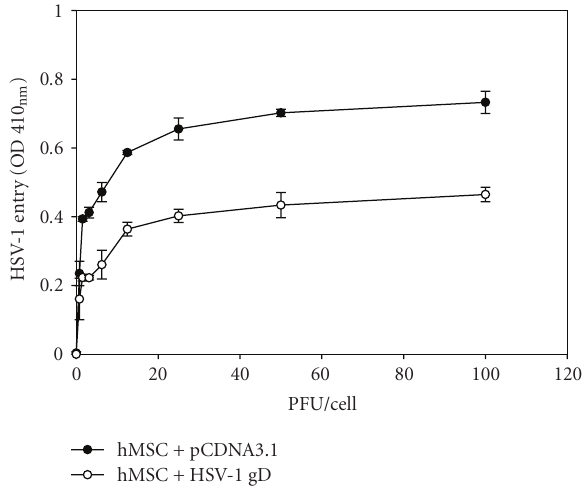
Figure 4: HSV-1 glycoprotein D (gD) receptors are important for infection of hMSCs. Cultured hMSCs were transfected with an HSV-1 gD expression plasmid (white dot) or with the empty vector pCDNA3.1 (black dot) and infected with HSV-1 at two fold dilution. Reporter enzyme activity, as a measurement of viral entry, was measured with spectrophotometer at 410